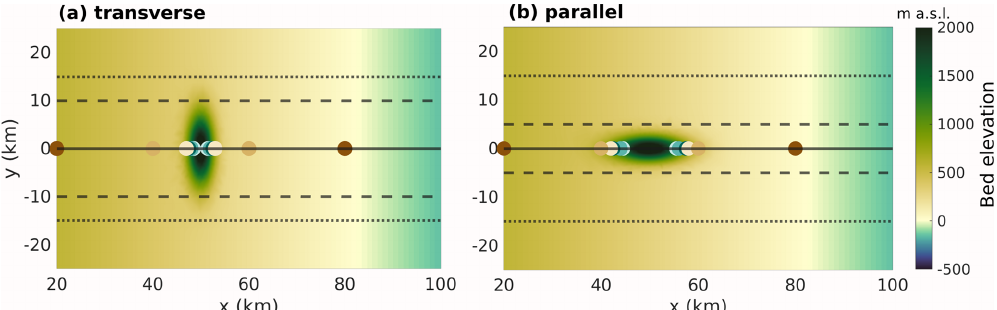
Figure 3. Bedrock elevation (ma.s.l.) used in the experiments where the nunatak is placed (a) transversely and (b) parallel to ice flow. Ice flow in this figure is from left to right. Transect lines show the position of the transects presented in Fig. 5a and b, and coloured circles show the locations for the ice surface evolution analysis presented in Fig. 5c and d following the same colours as the lines therein.